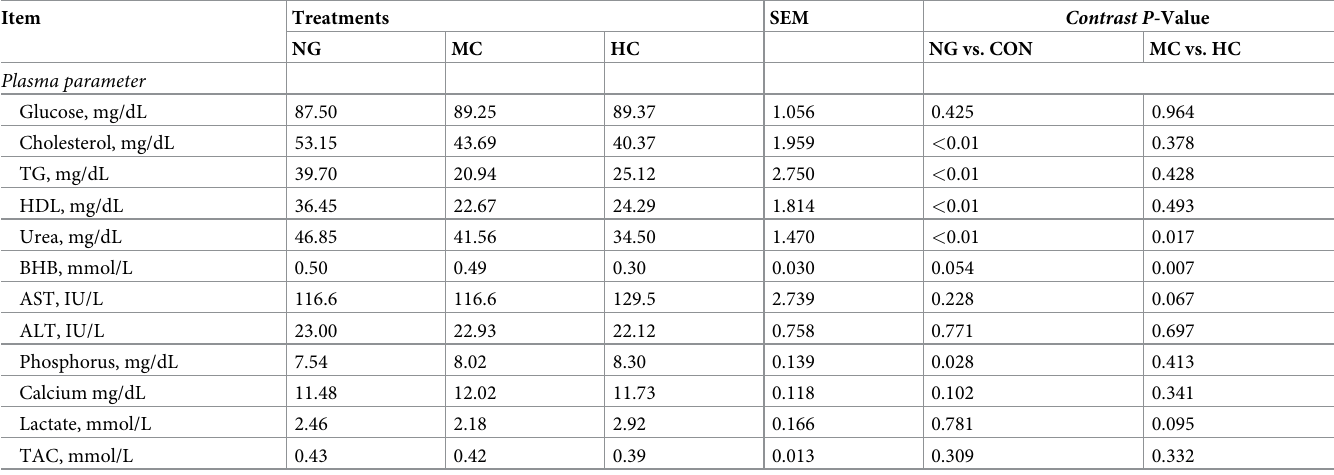
Table 3. Plasma parameters of lambs from different production systems.